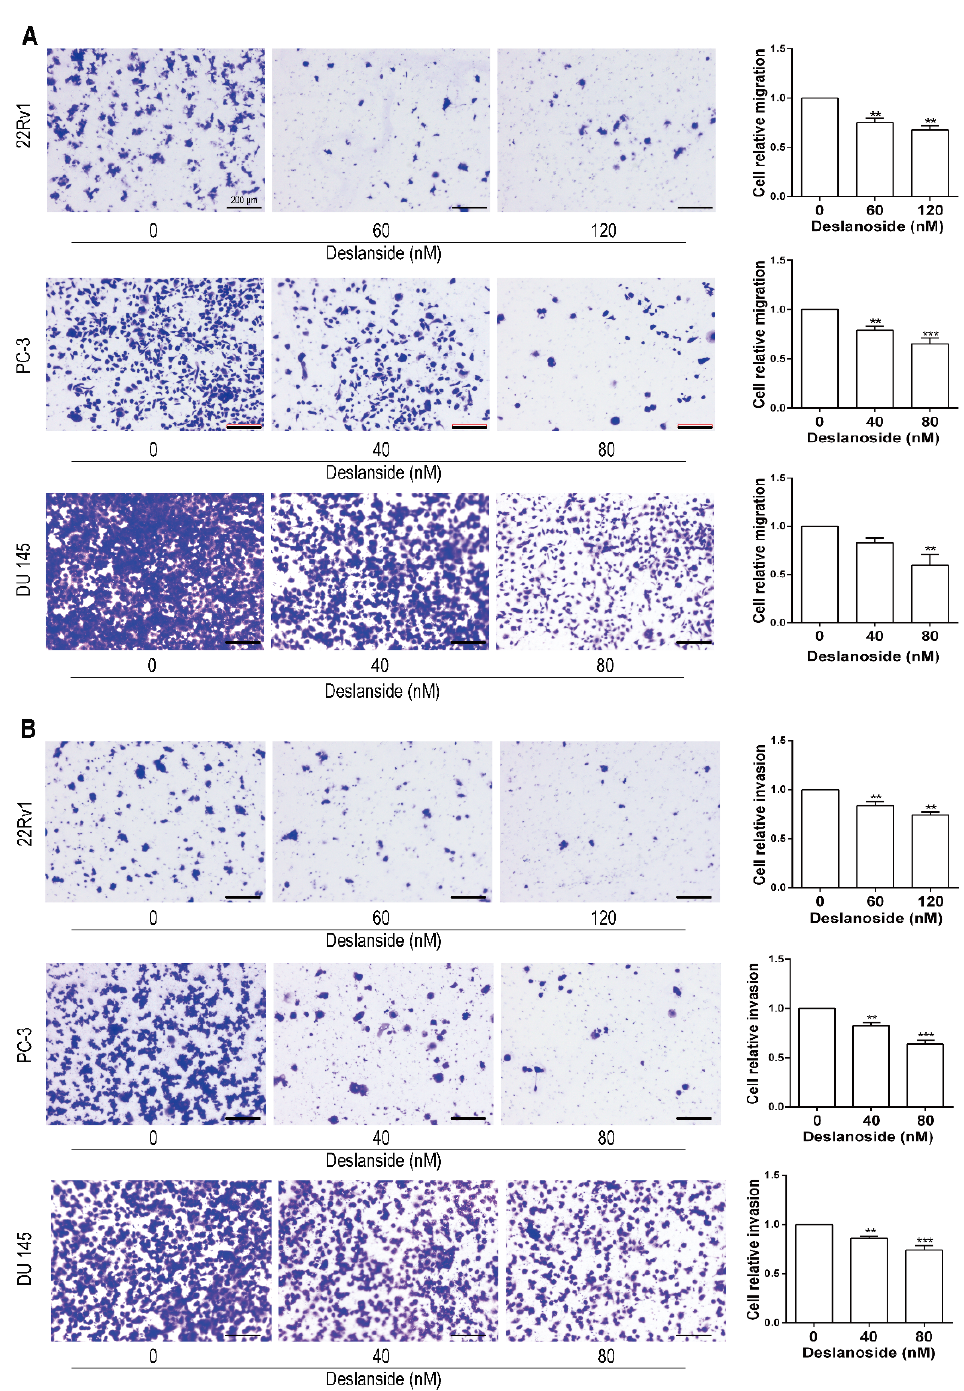
Figure 4. Deslanoside suppresses cell migration and cell invasion in human prostate cancer cells. ( A ) Deslanoside decreased the migratory capability of 22Rv1, PC-3, and DU 145 cells in a dose-dependent manner after treatment. ( B ) Effect and statistical analysis of invasion in three cell lines after treating deslanoside in transwell assays. Scale bars, 200 µ m. The Student’s t -test was used for the statistical analysis. ** p < 0.01; *** p < 0.001. Data are presented as mean ± SD of at least three independent